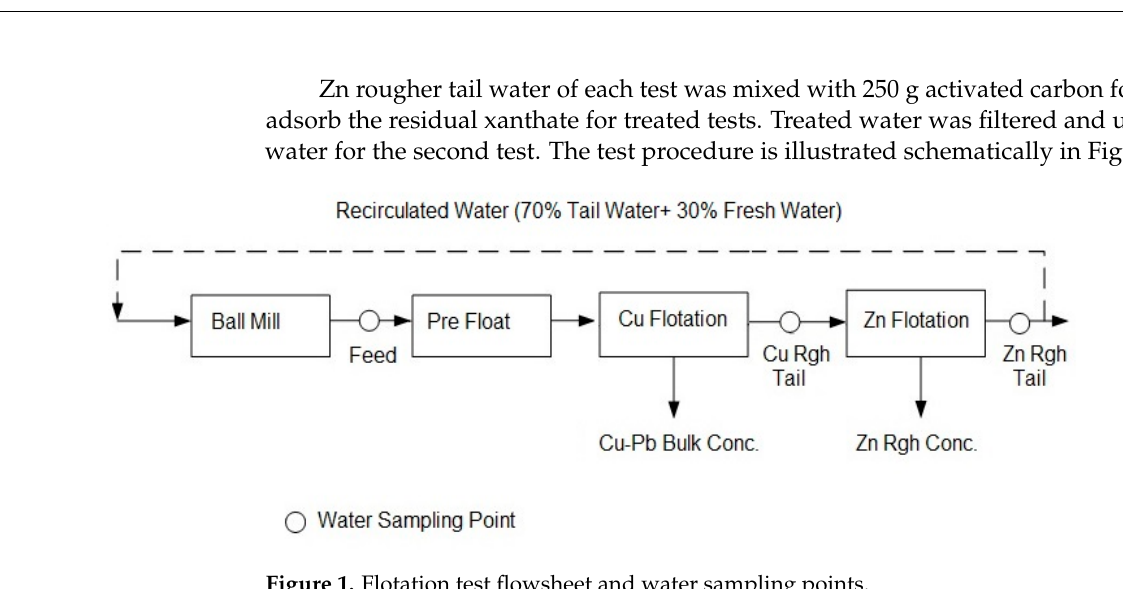
Table 3. Chemical composition (mg/L) of tap water used for flotation tests.